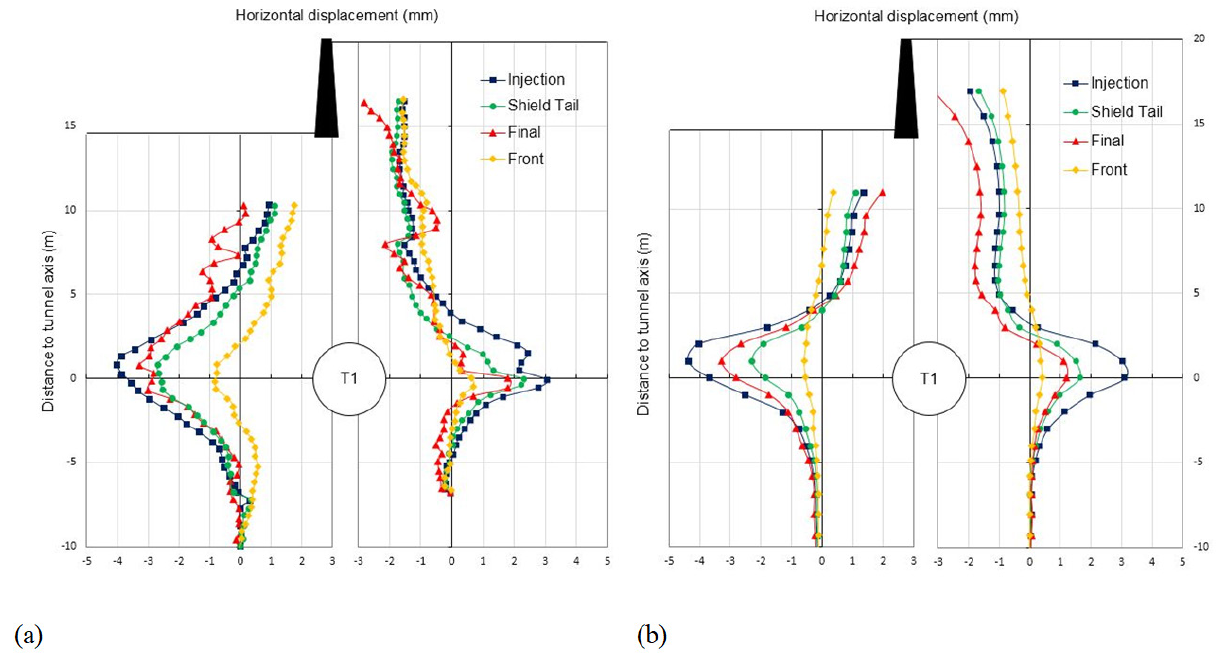
Figure 15: Lateral movements: (a) field data and (b) simulations.